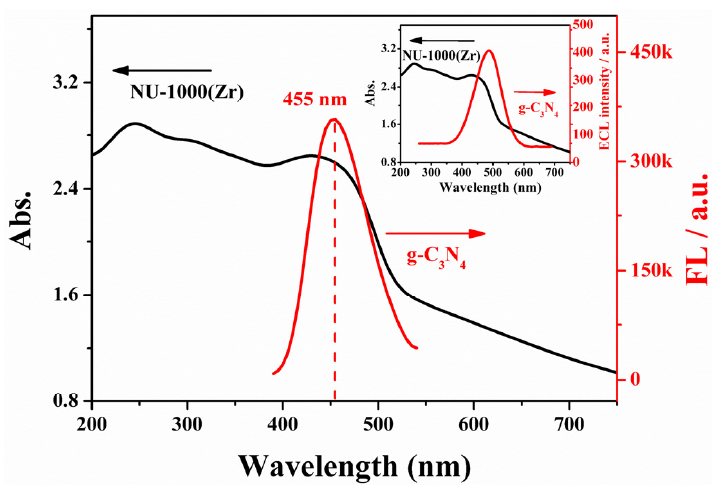
Figure 4. UV-vis absorption spectrum g-CN and FL emission spectrum of NU-1000(Zr) (the red curve in the inset is the ECL emission spectrum of g-CN [24,36,37]).